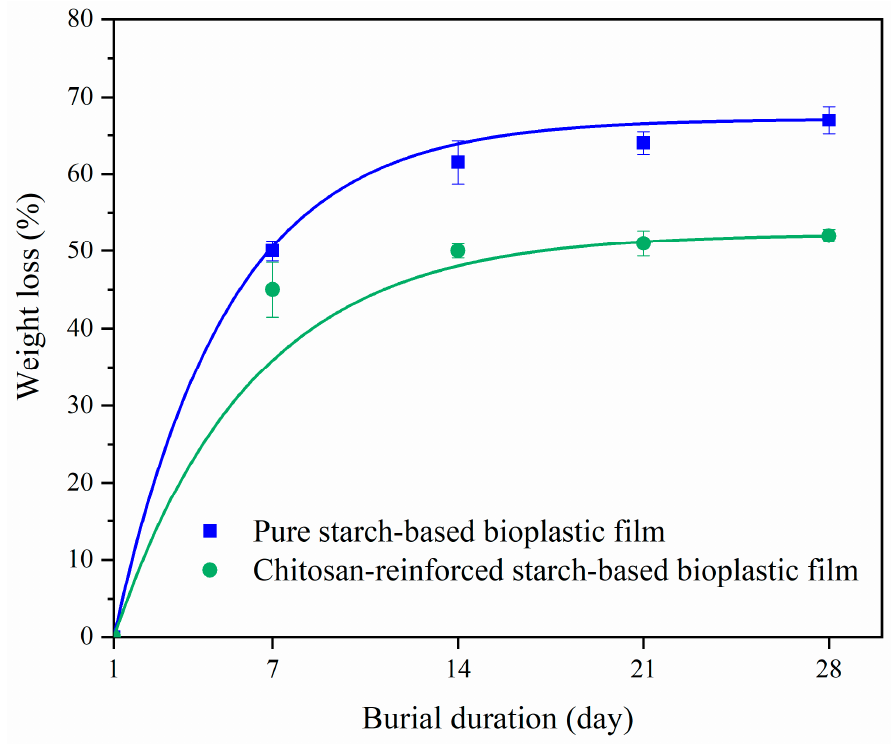
Figure 14. Weight loss percentages of pure starch and chitosan-reinforced starch-based bioplastic films during burial period.